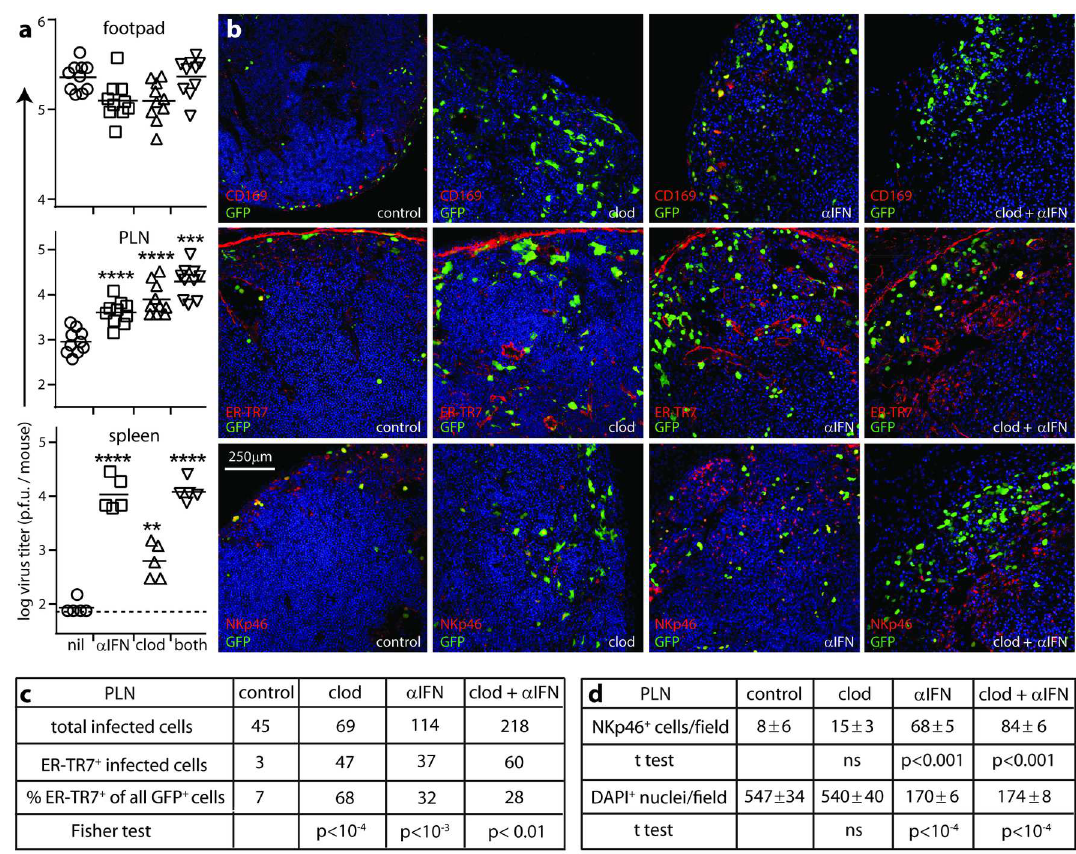
Fig 8. Comparison of SSM depletion and IFNAR blockade effects on PLN infection. (a). C57BL/6mice were depleted of SSM with liposomalclodronate (clod), given IFNAR blockingantibody ( α IFN), given both treatments, or neither (control), then infected i.f. with MCMV-GR (10 6 p.f.u.). 3 days later, organs were plaque-assayedfor infectiousvirus. Horizontalbars show means, other symbols show individuals. Dashedlines show assay sensitivity limits where abovethe y axis